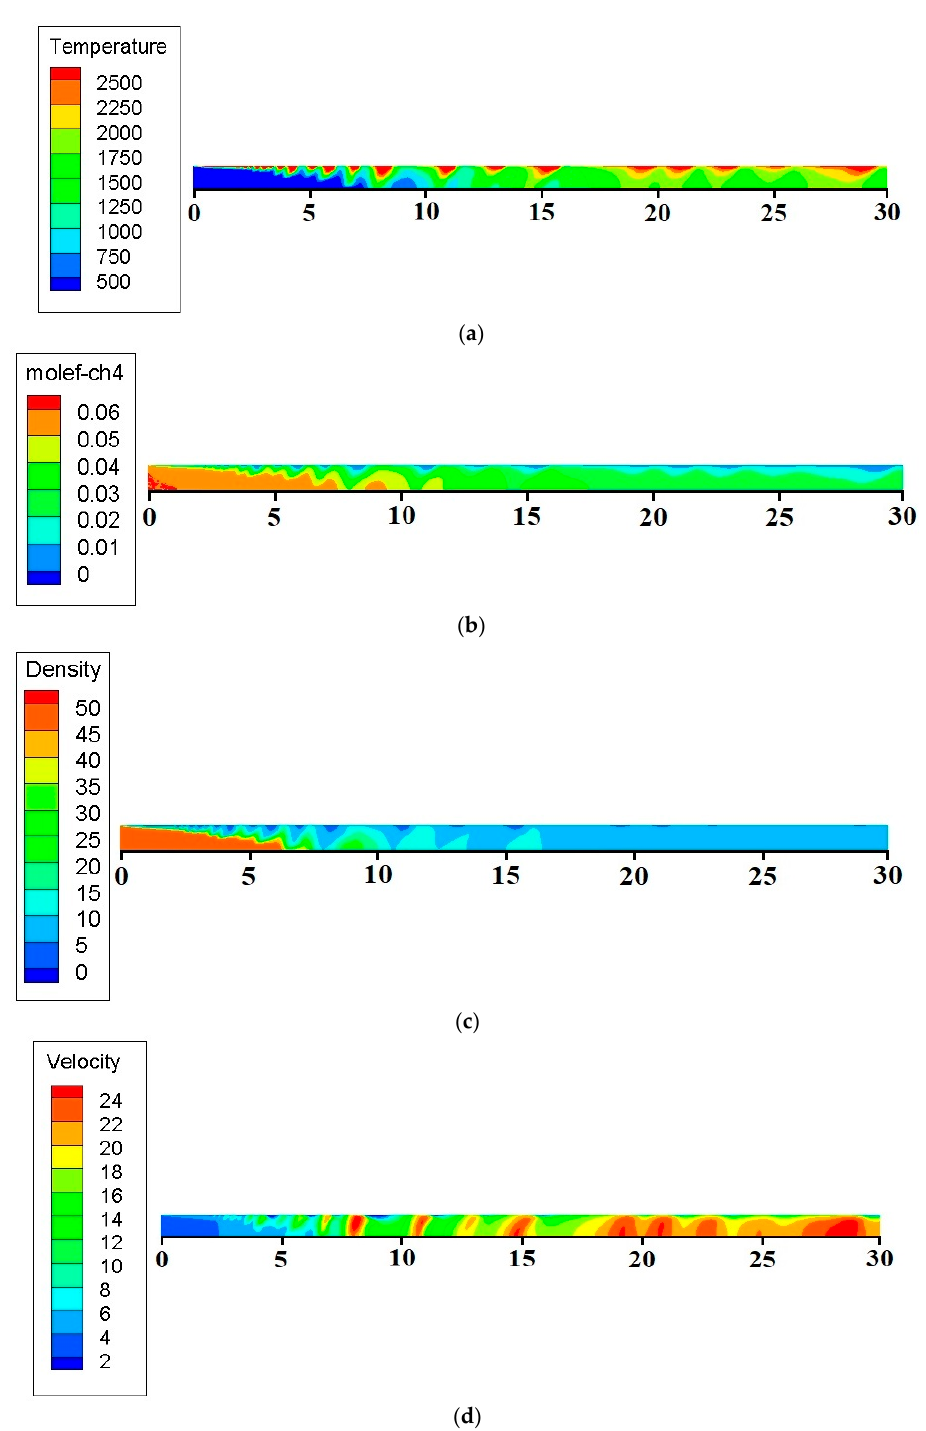
Figure 17. Temperature, concentration, density, and flow velocity distribution at 2 MPa. ( a ) Tem- perature distribution. ( b ) Methane concentration distribution. ( c ) Density distribution. ( d ) Velocity distribution.